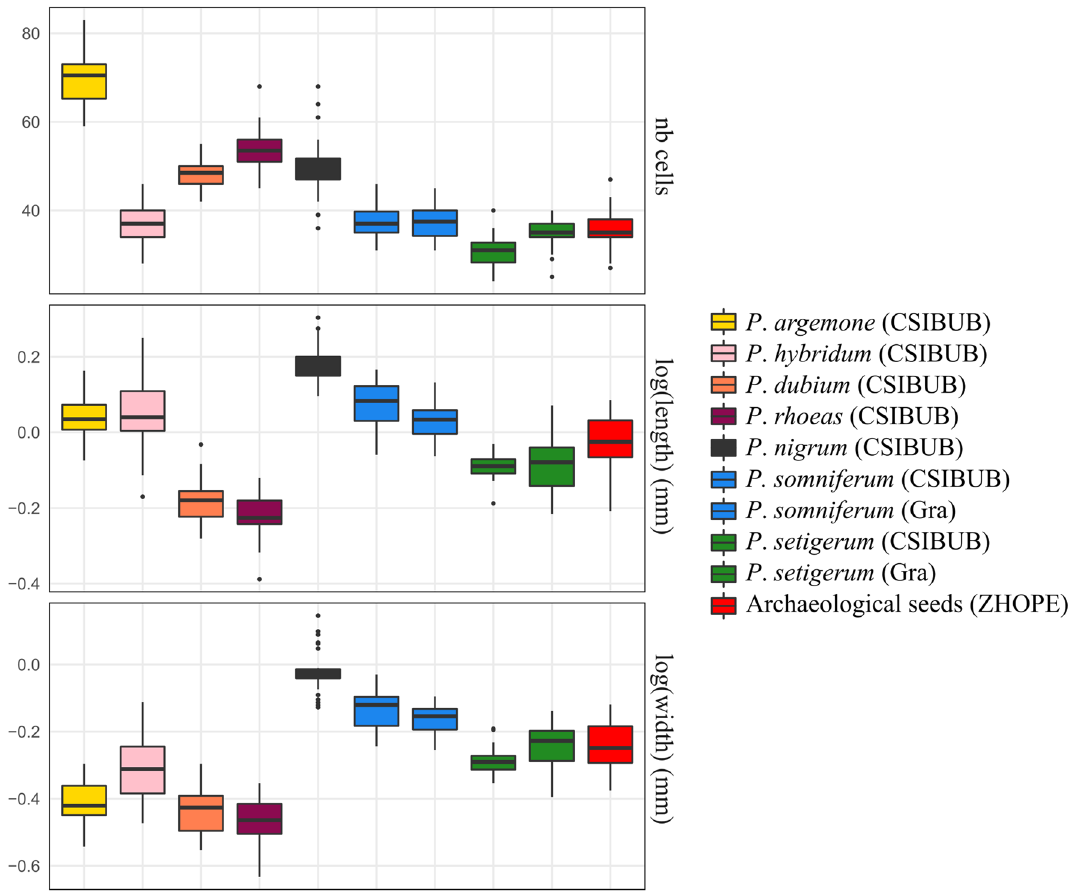
Figure 1. Boxplot of measurements (number of cells, length, width,) made on the modern seeds. Length and width are (natural) logged. Archaeological seeds are presented in